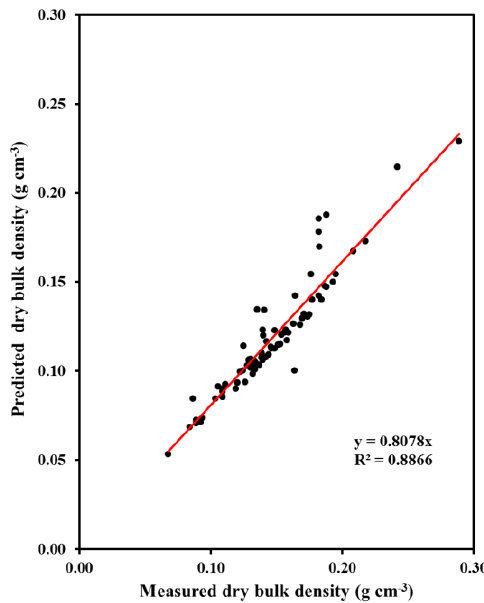
Figure A3. Regression of predicted dry bulk density on measured dry bulk density for a set of Indonesian peats (intact peat swamp forest, logged forest and oil palm plantation), omitting samples taken at depths less than 100 cm.